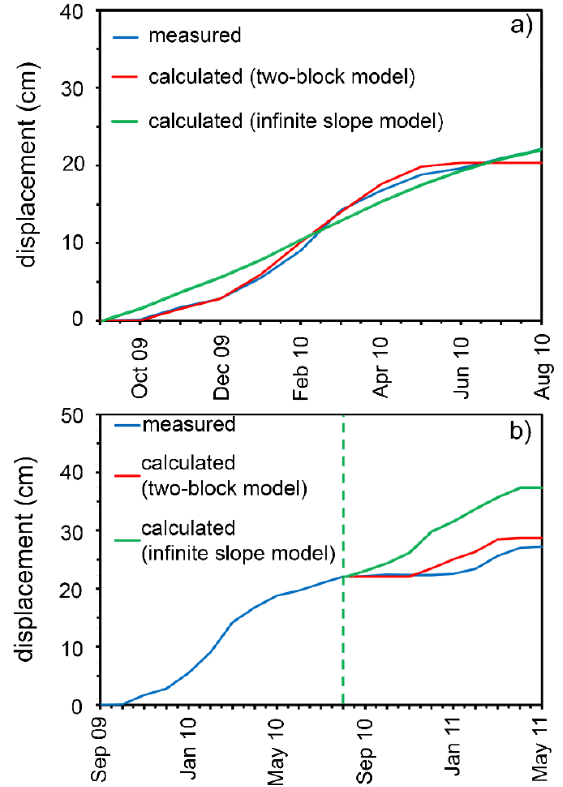
Figure 9. Prediction of soil displacement carried out by means of the proposed approach, referring to the time period from August 2010 to May 2011: ( a ) rain recordings, ( b ) horizontal displacement. The dotted line indicates the beginning of prediction.